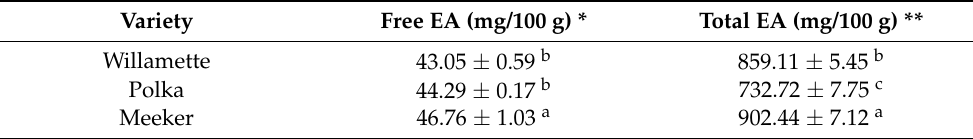
Table 1. Free and total EA content in the DRS of all examined varieties. Variety Free EA (mg/100 g) * Total EA (mg/100 g) ** Willamette 43.05 ± 0.59 b